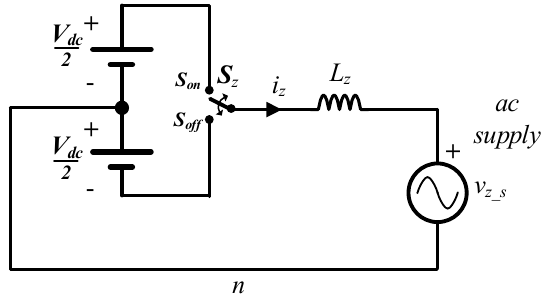
Figure 3. Per-phase equivalent circuit of the grid-tied converter.